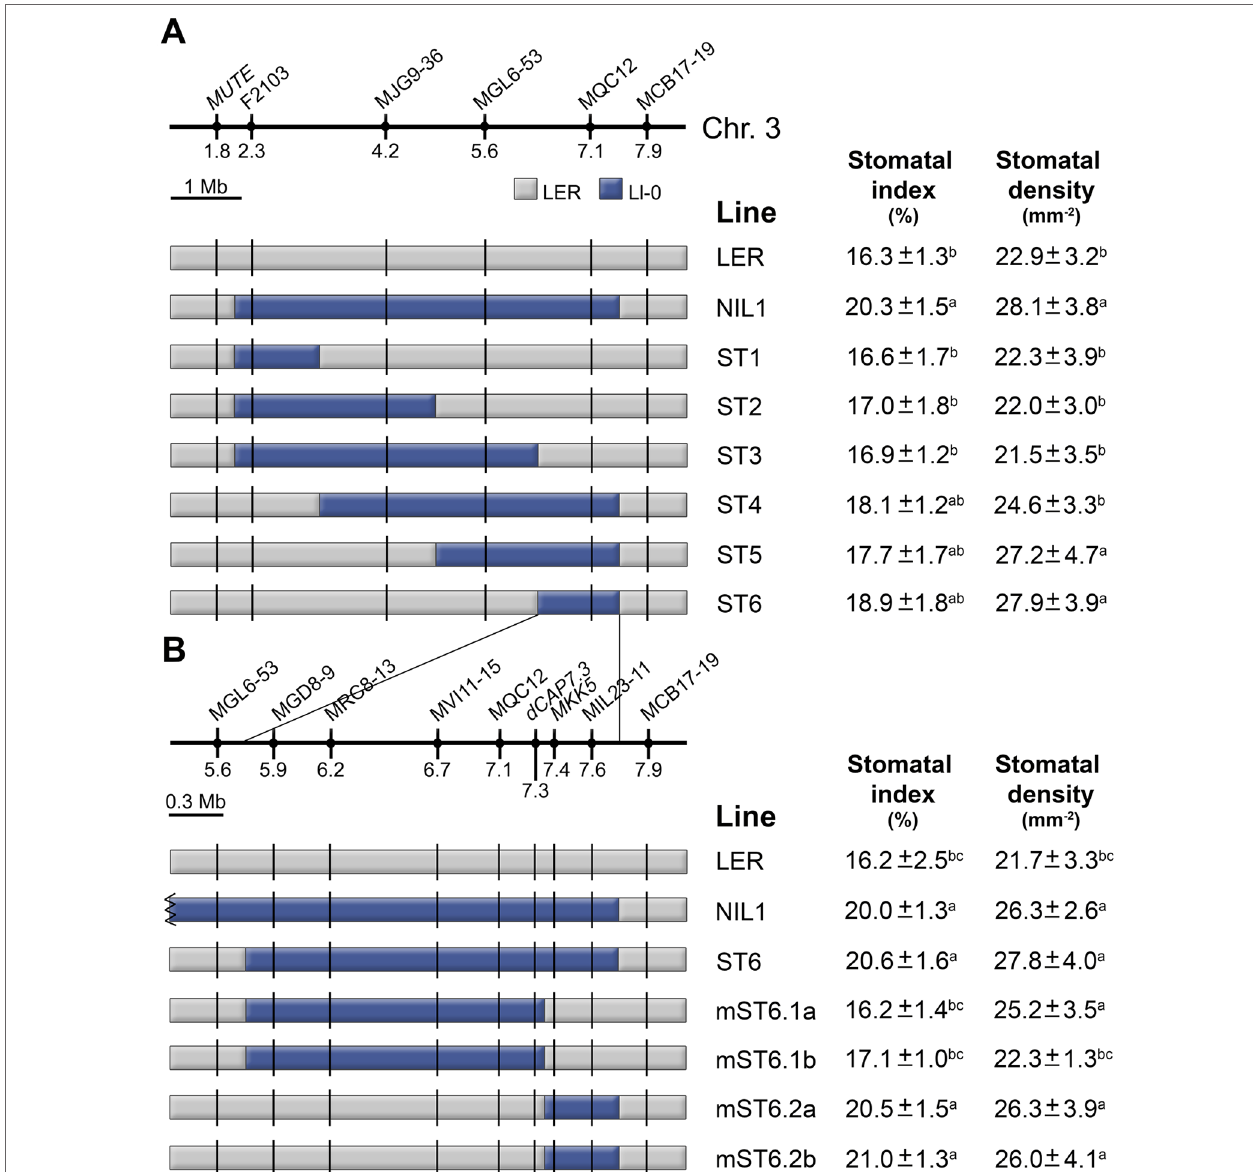
FIGURe 6 | Fine mapping of MID3 . (A) L ER lines with Ll-0 overlapping introgression fragments derived from NIL1. (B) The region introgressed in ST6 is expanded to show the newly developed markers and the precise recombinant breakpoints for proximal and distal mini-STAIR (mST) lines. Names and position (Mb) of markers are shown above each panel. Color codes indicate Landsberg (gray) and Ll-0 (blue) alleles. Stomatal index and density were scored in the adaxial cotyledon epidermis at 21 dag for all lines in growth chamber experiments. Each panel shows the mean ± SE of 10–15 plants. Significant phenotypic differences ( P ≤ 0.05; Tukey's test) are indicated with letters. a: differing from L ER ; b: differing from NIL1; c: differing from